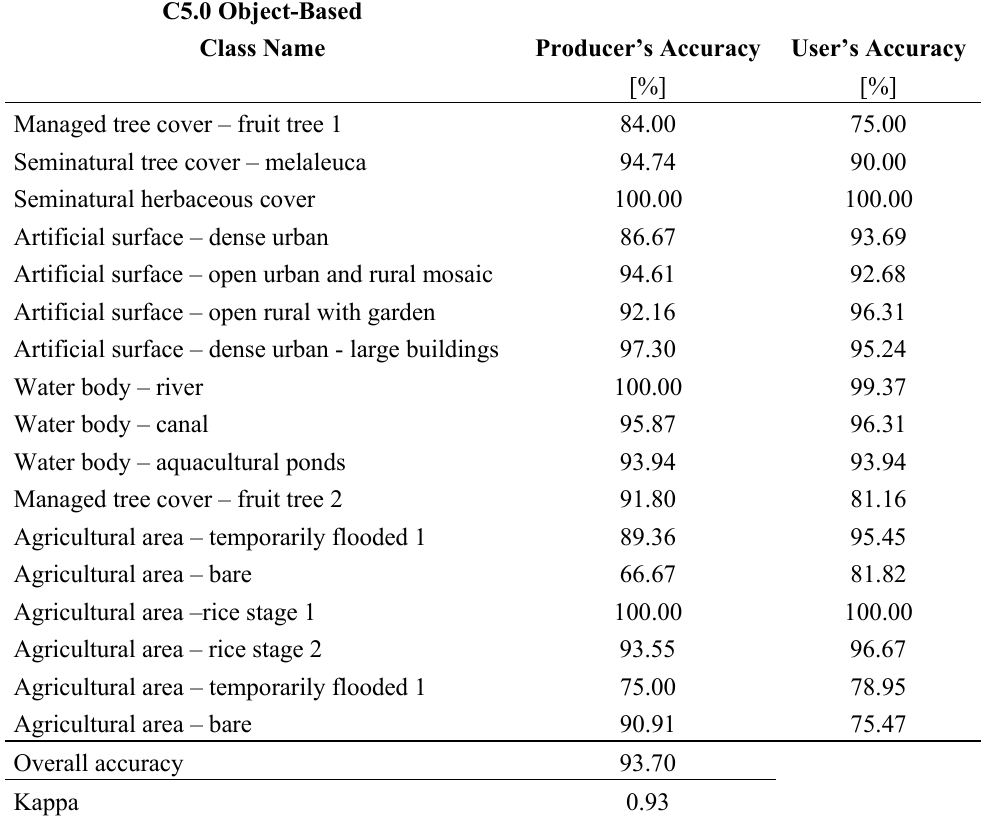
Table 1. Producer’s, user’s and overall accuracy and kappa coefficient for C5.0 object-based classification result of Rapid Eye-16-tile-mosaic (2010-01-27).